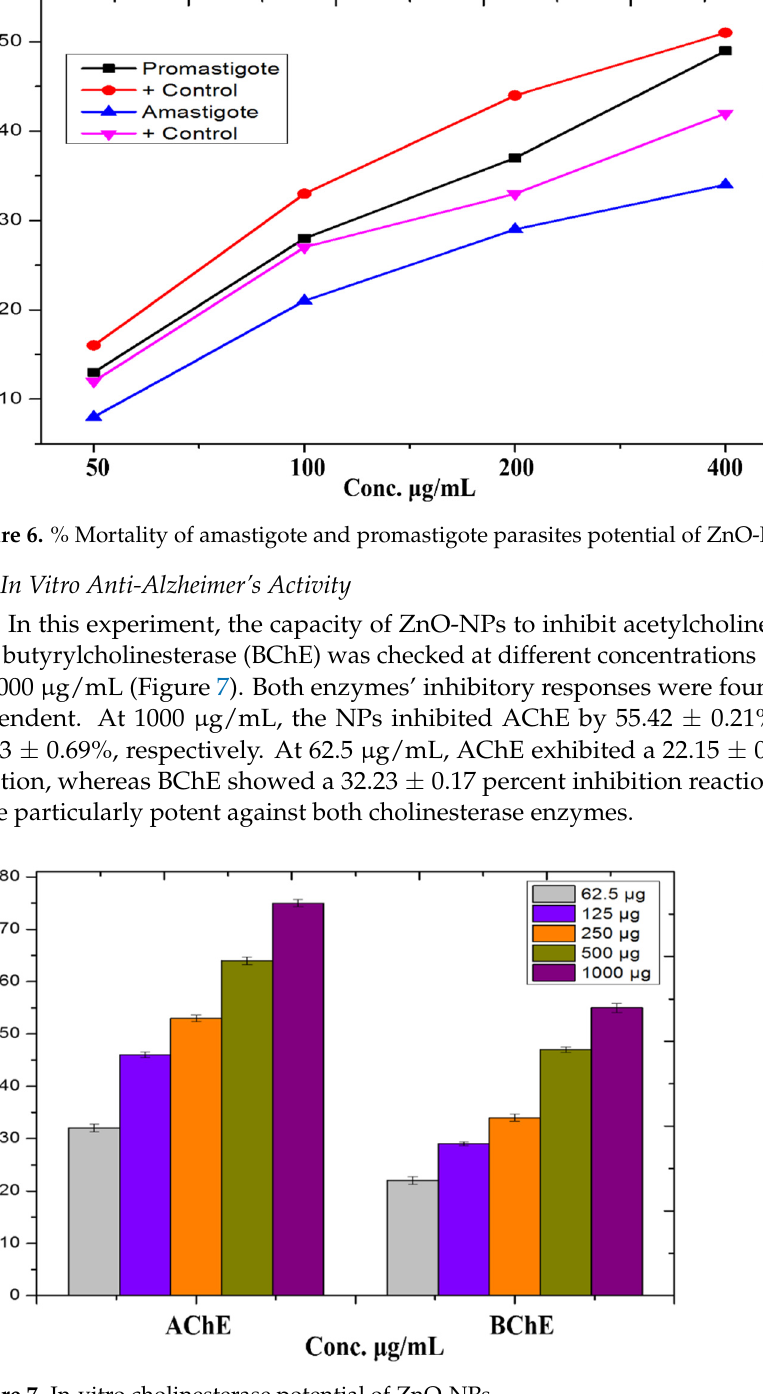
Figure 7. In-vitro cholinesterase potential of ZnO-NPs.